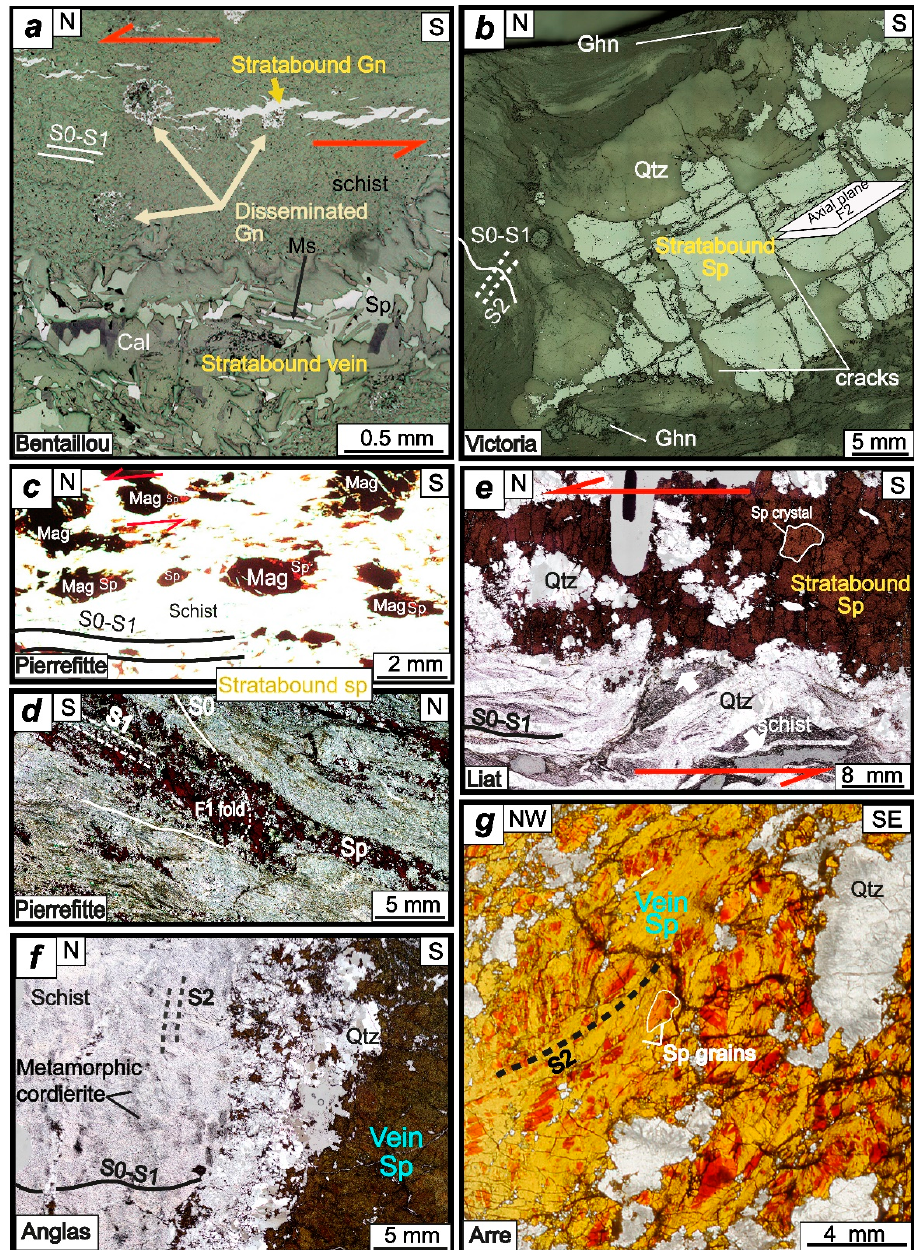
Figure 9. Microphotographs showing characteristics textures in the three mineralization types. ( a ) Bentaillou disseminated mineralization truncated by stratabound mineralizations (reflected light); ( b ) stratabound Victoria folded mineralization which intersects gahnite D 1 metamorphic mineral (reflected light); ( c ) syn-kinematic sphalerite which crystallizes in asymmetric pressure shadows around clasts of magnetite in Pierrefitte mine (transmitted light); ( d ) sphalerite mineralization from Pierrefitte mine parallel to S 1 and in F 1 isoclinal fold hinge. Mineralization intersects S0 stratification (transmitted light); and ( e ) stratabound sphalerite and quartz mineralizations which intersect pelitic host rock in Liat mine. Sphalerite is interpreted syn-kinematic D 1 (transmitted light); ( f ) vein mineralization in Anglas mine which intersect S 0 -S 1 and parallel to S 2 cleavage marked by metamorphic cordierite (transmitted light); and ( g ) deformed and recrystallized vein sphalerite in Arre deposit. The two textures are identified with white line Recrystallization area in yellow marked S 2 cleavage (transmitted light). Mineral abbreviations: Cal—Calcite; Ghn—Gahnite; Gn—Galena; Mag—Magnetite; Ms—Muscovite; Qz—Quartz; Sp—Sphalerite.